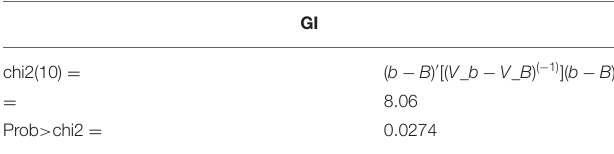
TABLE 4 | Hausman test. TABLE 5 | DDD regression results at the national level.